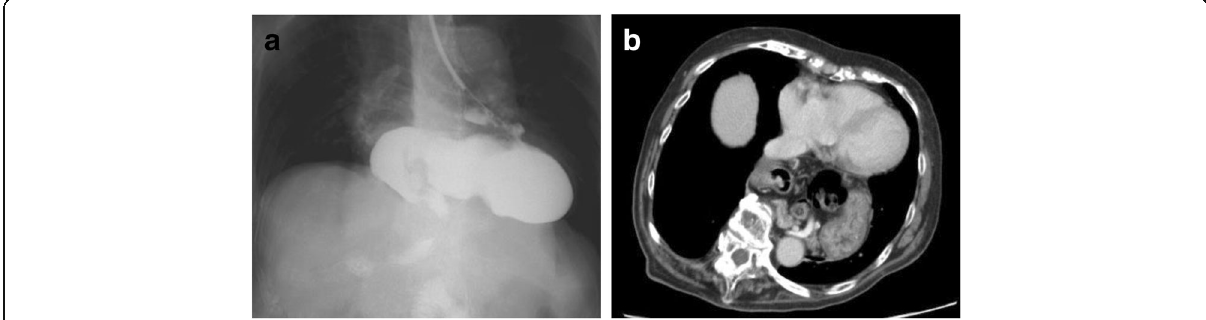
Fig. 2 Giant hiatal hernia. a An upper gastrointestinal contrast study showed an upside-down stomach. b Computed tomography revealed a giant hiatal hernia with the intrathoracic stomach located behind the heart and compressing the left